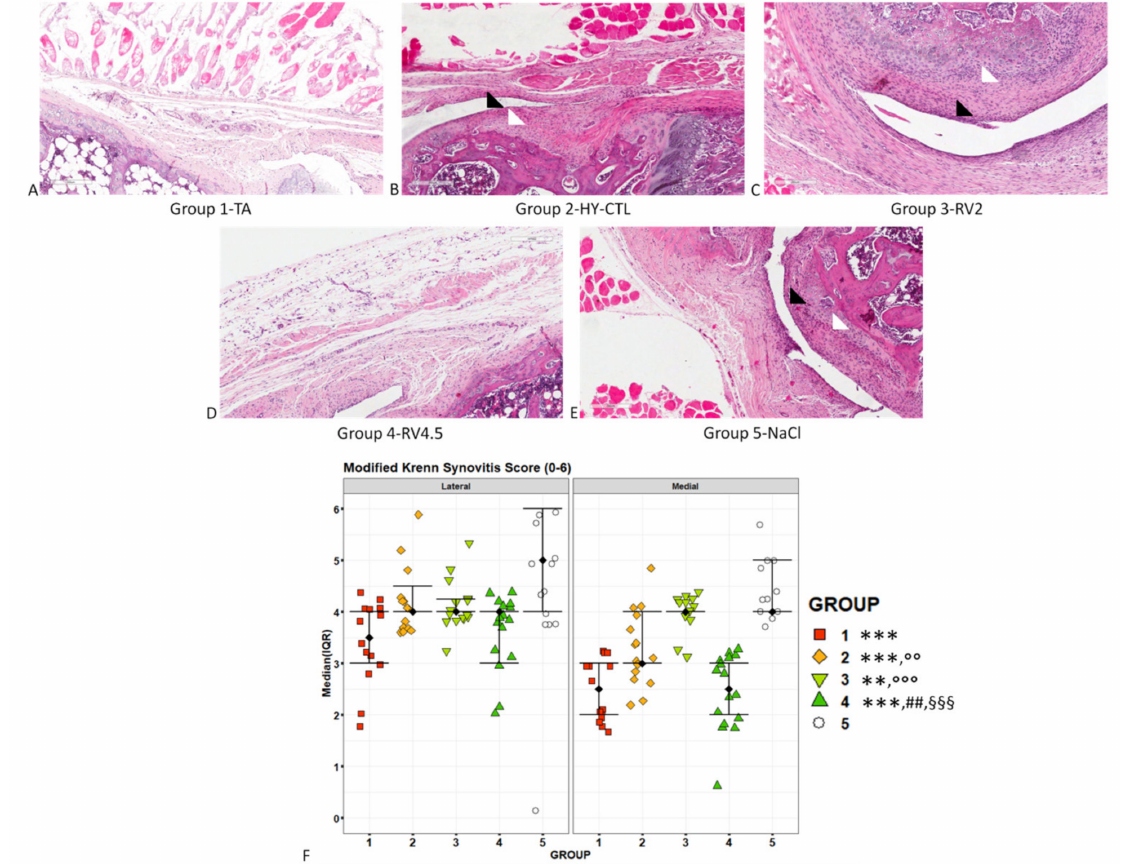
Figure 6. Histopathological assessments of synovial membranes. Histological images of medial synovial membranes treated with i.a injection of TA ( A ), HY-CTL ( B ), RV2 ( C ), RV4.5 ( D ) and NaCl ( E ). Hematoxylin and eosin (H&E) staining, magnification 10 × , bar = 200 µ m. ( F ) Scatter plot of modified Krenn synovitis score; black square dots indicate the median and error bars indicate IQR. The selected CLM (likelihood ratio test: χ 2 = 114.6, p < 0.0005) takes into account a scale e ff ect of both factors, highlighting their significant e ff ects (‘treatment’: χ 2 = 79.3, p < 0.0005; ‘joint compartment’: χ 2 = 43.2, p < 0.0005) on the modified Krenn synovitis score.Post-hoc pairwise comparisons (1 symbol: p < 0.05; 2 symbols: p < 0.005; 3 symbols: p < 0.0005): * All treatment groups versus NaCl. ◦ HY-CTL, RV2 and RV4.5 versus TA. # RV2 and RV4.5 versus HY-CTL. § RV4.5 versus RV2. Significant lower modified Krenn synovitis scores were found in the medial joint compartment compared to the lateral one ( − 15%, p < 0.0005). Black arrowheads: enlargement of the synovial lining cell layer; white arrowheads: increased cell density in the synovial